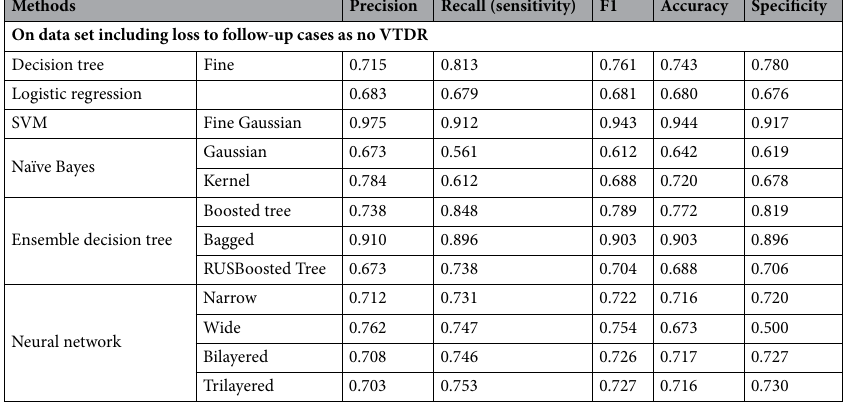
Table 5. Performance parameters of trained model on data set including loss to follow-up cases. VTDR vision- threatening diabetic retinopathy, SVM support vector machine.